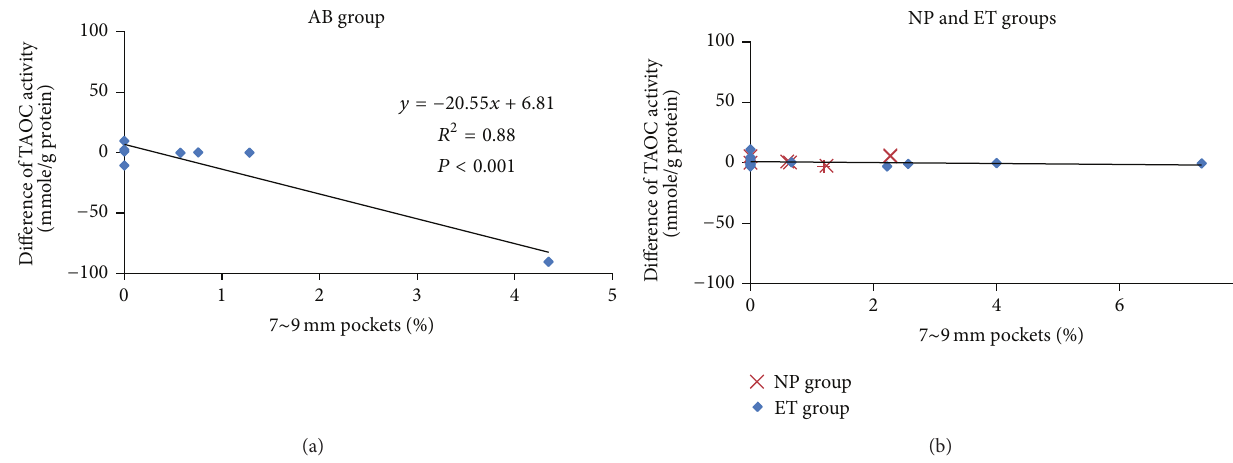
Figure 3: Scatterplots of total antioxidant capacity (TAOC) differences and sum of baseline 7 ∼ 9 mm pocket percentages. (a) Abandoned (AB) group and (b) nonprogress (NP) group and effective treatment (ET) group.